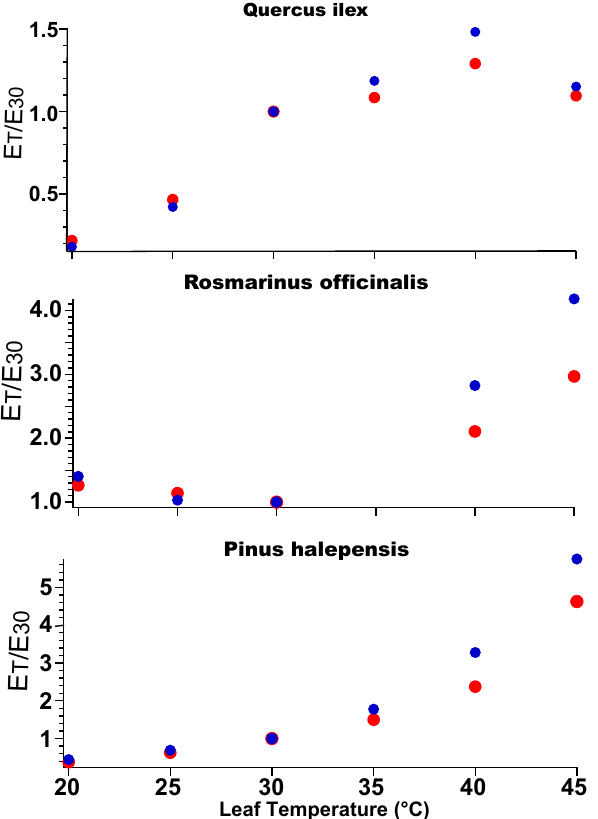
Fig. 6. An example of ( − )/( + ) - α -pinene emission which was nor- malized by dividing by emission at 30 ◦ C from different plant species in dependency with temperature. The red points represent normalized ( − )- α -pinene emissions and the blue points show the normalized ( + ) - α -pinene emissions.